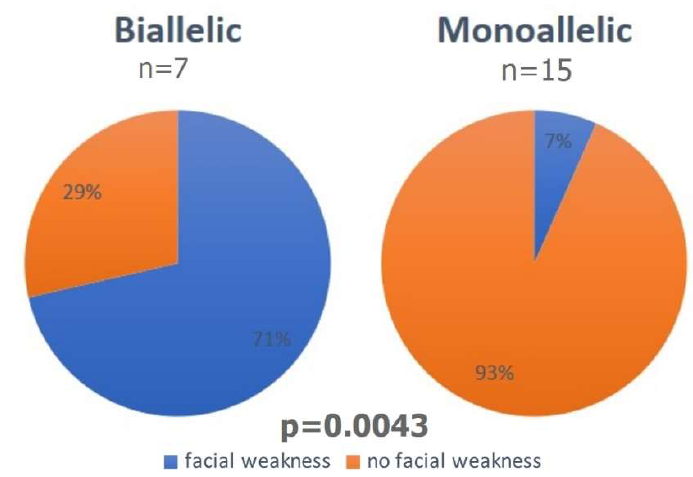
Figure 4. Facial weakness in biallelic and monoallelic RYR1 families.